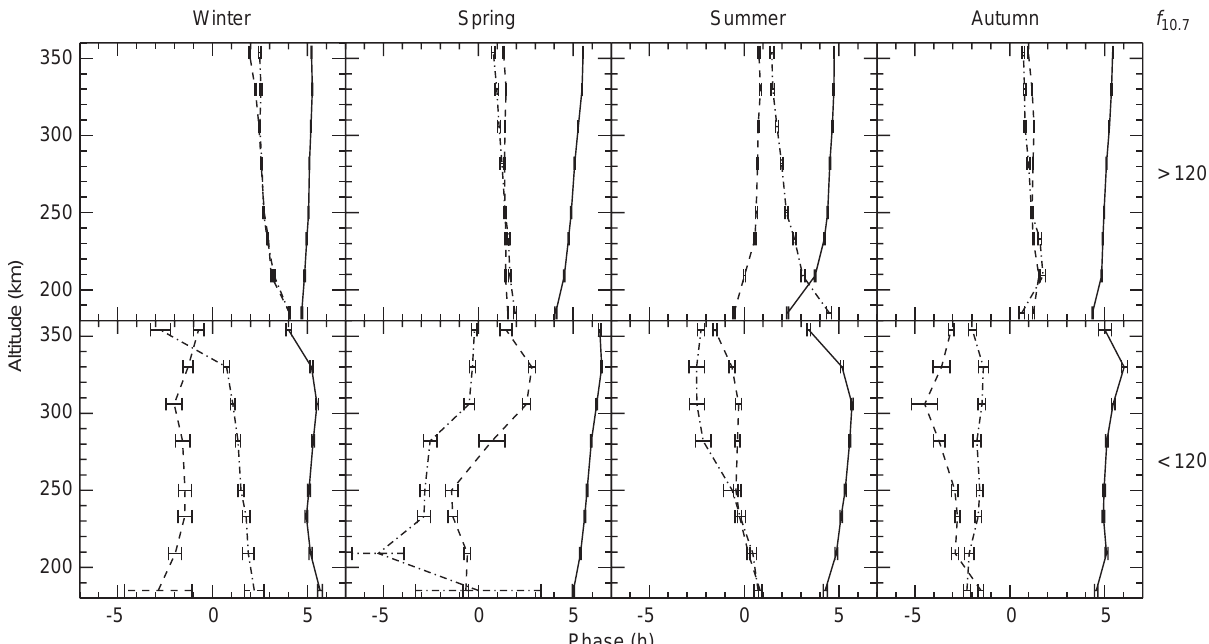
Fig. 6. Height phases profiles: (cid:47)